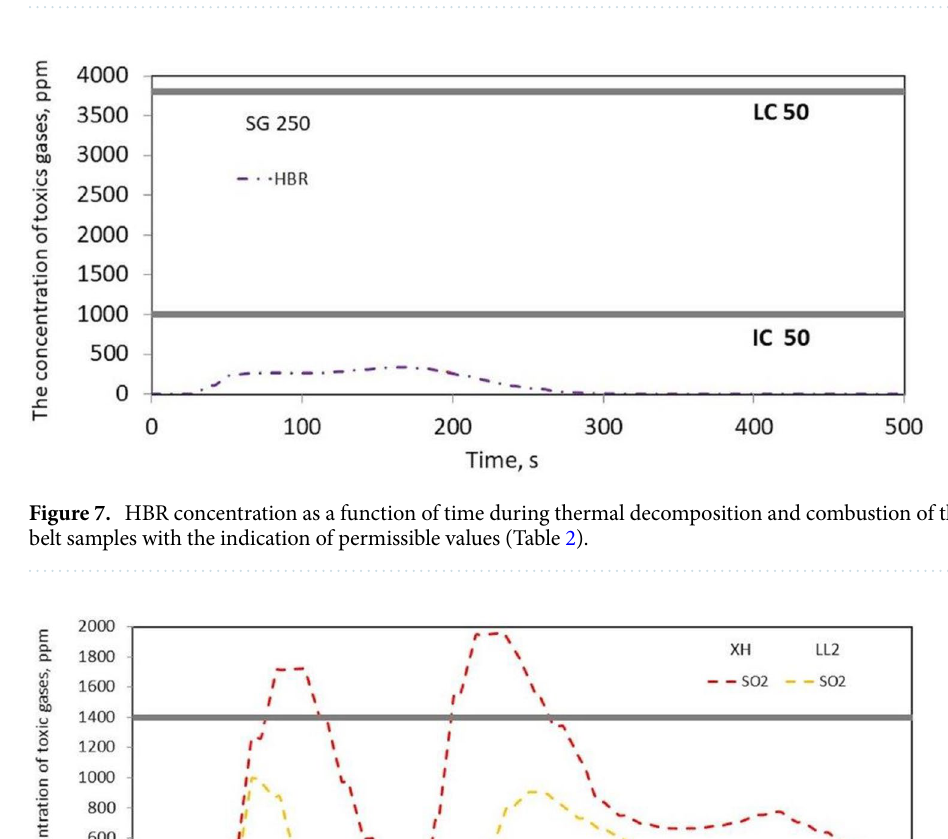
Figure 6. HCN concentration as a function of time during thermal decomposition and combustion of the tested belt samples with the indication of permissible values (Table 2).